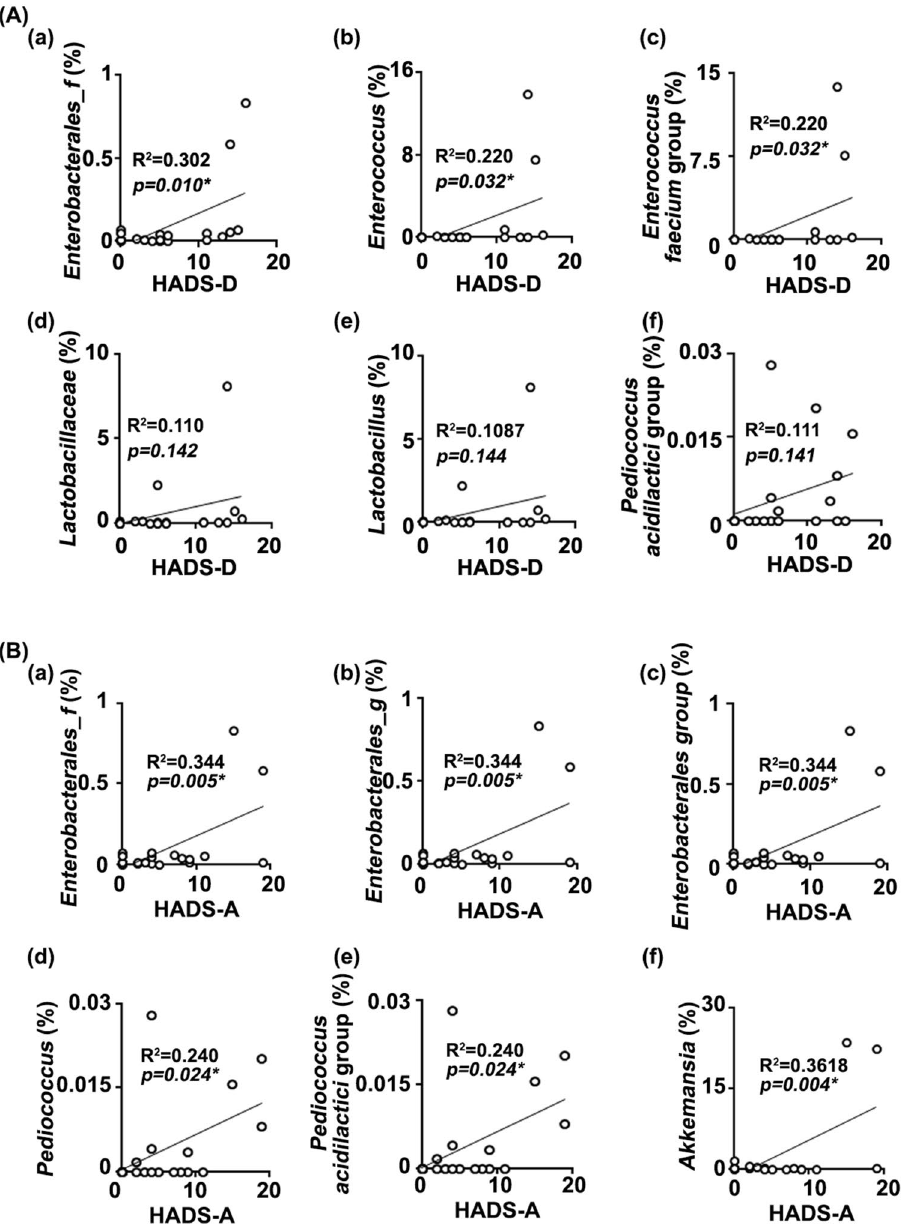
Figure 4. The relationship between HADS and gut microbiota composition. ( A ) The relationship between HADS-D and gut microbiota composition: (a) Enterobacterales_f, (b) Enterococcus , (c) Enterococcus faecium group, (d) Lactobacillaceae, (e) Lactobacillus, and (f) Pediococcus acidilactici group. ( B ) The relationship between HADS-A and gut microbiota composition: (a) Enterobacterales_f, (b) Enterobacterales_g, (c) Enerobacterales group, (d) Pediococcus, (e) Pediococcus acidilactici group, and (f) Akkemansia. HV n = 6; IBD/ D − n = 8; IBD/D + n =